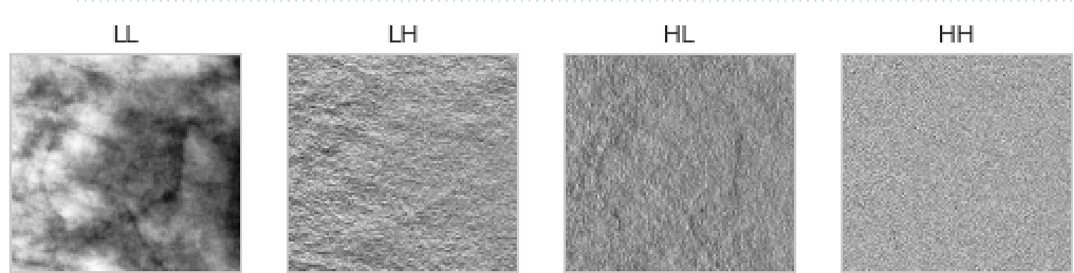
Figure 12. Comparison of the approximate coefficient (LL) and the detailed subbands ( LH horizontal, HL vertical, HH diagonal), also known as high